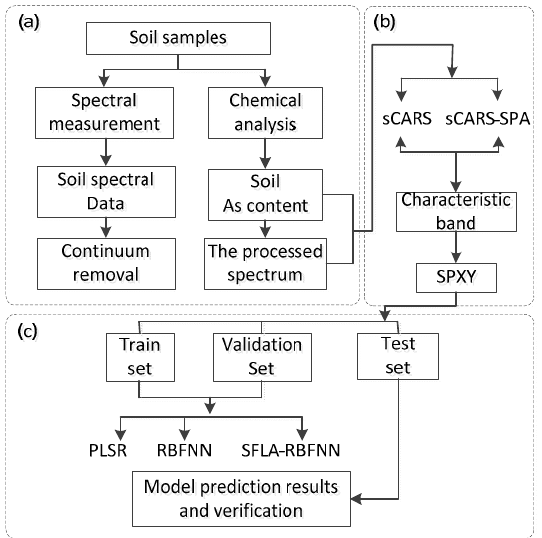
Figure 3. The flowchart for estimation of soil arsenic (As) content: ( a ) data acquisition and preprocessing; ( b ) characteristic wavelength selection; ( c ) modeling and verification.